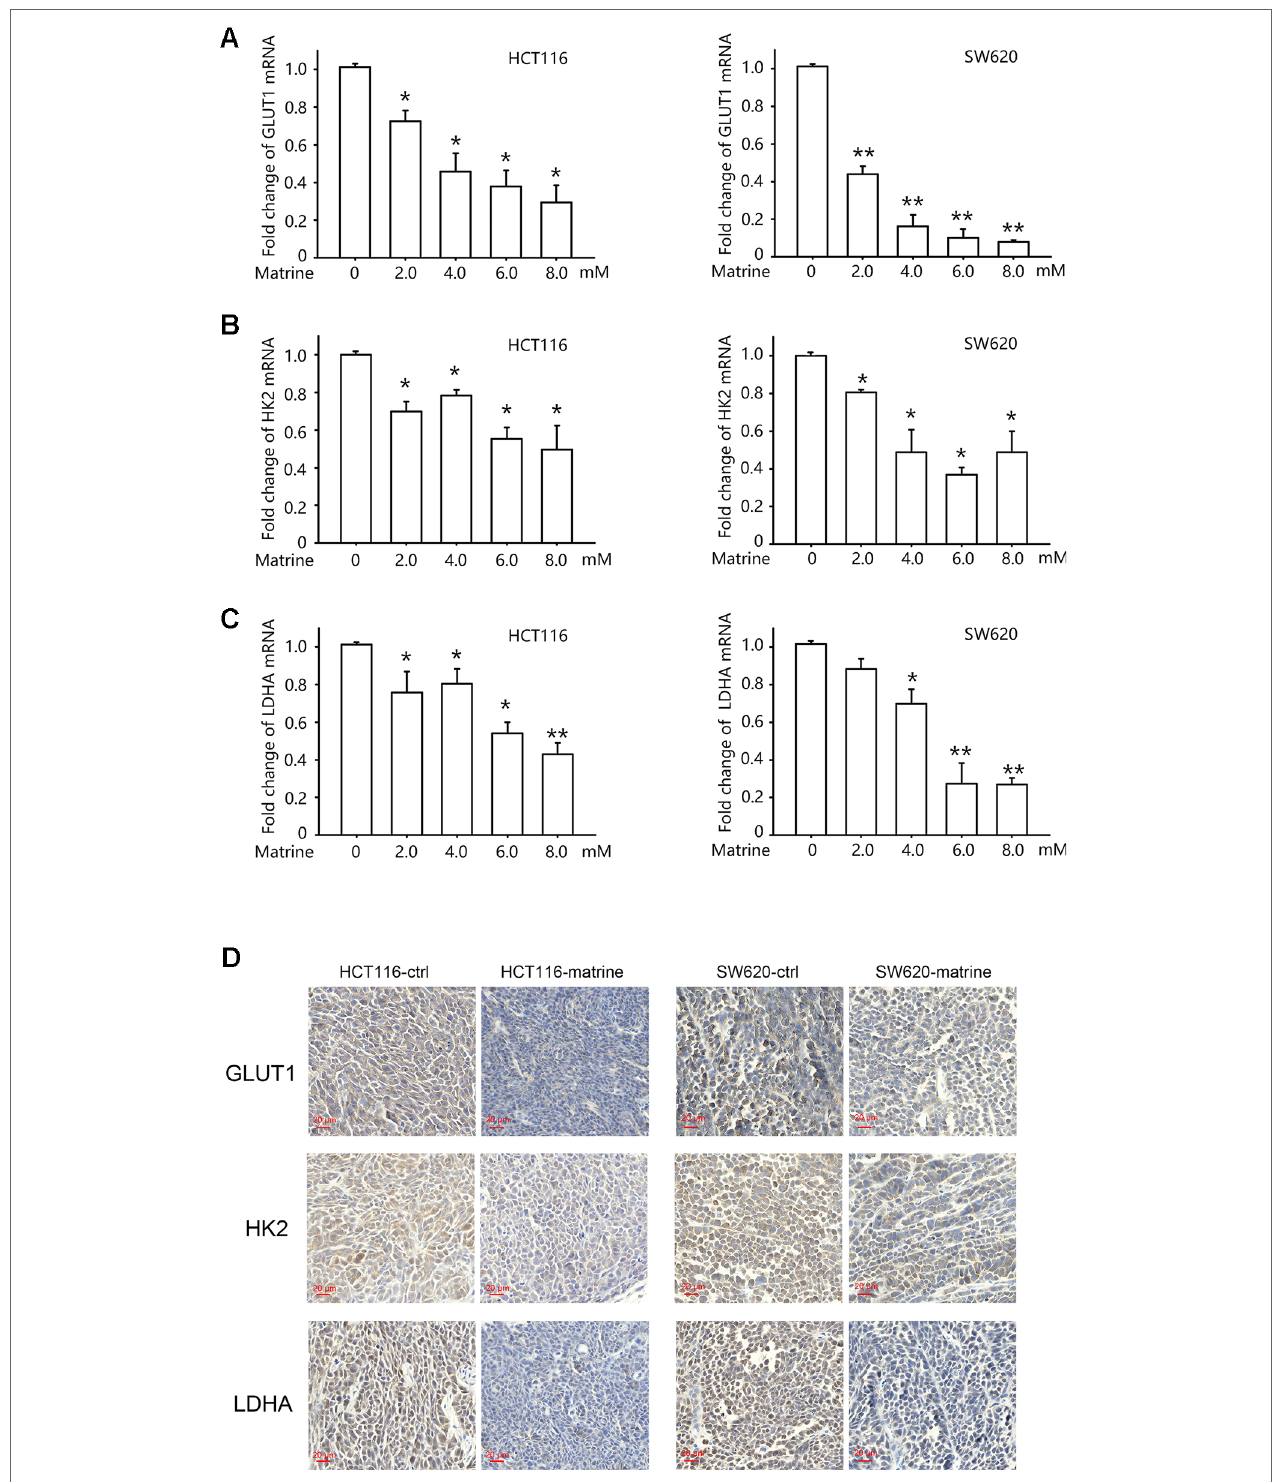
FIGURE 4 | Matrine inhibited the transcription of glucose metabolism-related genes in colon cancer cells. (a – C) Quantitative real-time-PCR analysis of GLUT1, HK2, and LDHA in HCT116 and SW620 cells following treatment with 0~8.0 mM matrine for 12 h. Data were expressed as mean ± SEM, n = 4~6. *, P < 0.05. **, P < 0.01. (D) Immunohistochemistry showing the expression of GLUT1, HK2, and LDHA in mouse xenograft